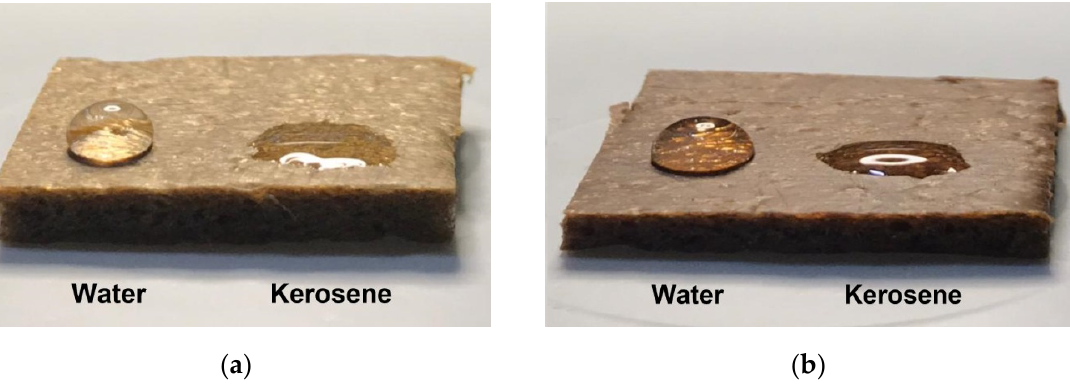
Figure 7. Comparison of the contact angle of the water and kerosene on the NRF surface of ( a ) FS-03 and ( b ) FH-05